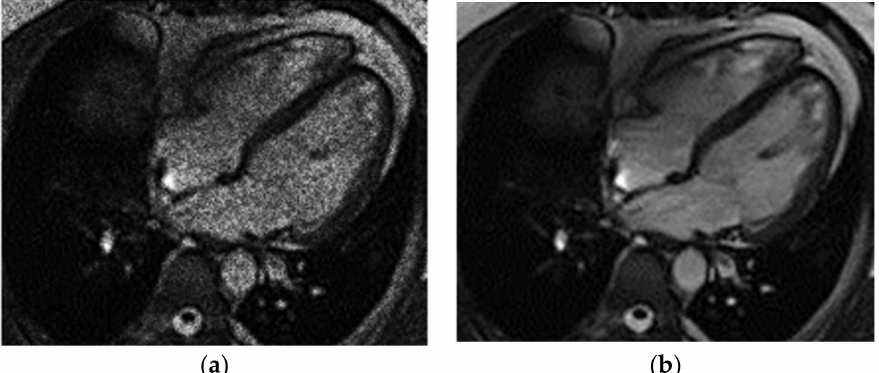
Figure 2. Heart MRI: ( a ) image with white noise and ( b ) denoised